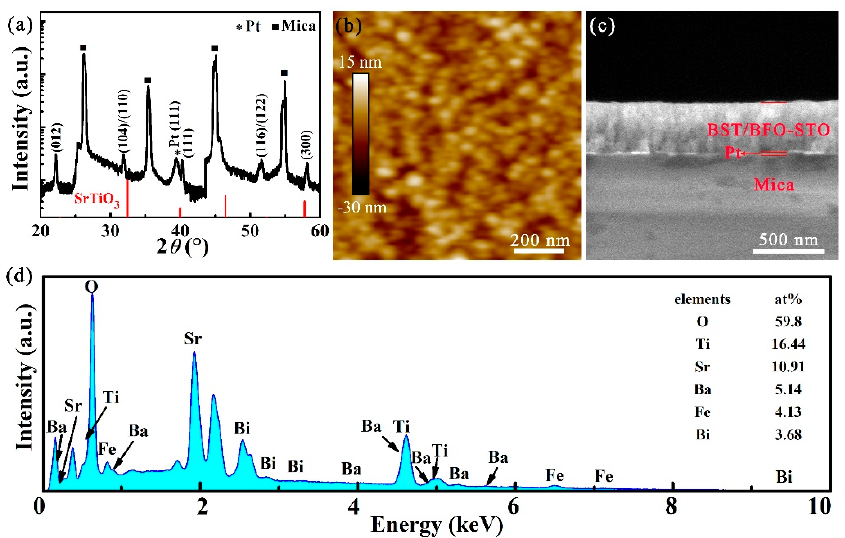
Figure 1. ( a ) X-ray diffraction pattern in the 2 θ range of 20–60°, ( b ) AFM, ( c ) Cross-sectional SEM images and ( d ) EDS spectrum of BST/0.4BFO-0.6STO thin film. The bipolar P-E loops for the BST/0.4BFO-0.6STO film in Figure 2a are measured from a low electric field to3000 kV cm − 1 at room temperature, at a frequency of 10 kHz. Figure 2b presents the corresponding energy storage parameters of the W , W rec , W loss and η at various electric fields determined by P-E loops. The W rec and η extrapolated from a bipolar P - E loop under E b (3000 kV/cm) are 62 J cm − 3 and ~74%, respectively, which is a relatively high level among the flexible dielectric films [37,50]. It can be seen that the P m and P r are 63.52 μ C cm − 2 and 6.73 μ C cm − 2 , respectively, which contributed a great Δ P = 56.79 μ C cm − 2 ,and the result is beneficial for energy storage performance. This small P r can be due to the fact that BiFeO 3 -SrTiO 3 is a relaxor ferroelectric and BST is paraelectric.